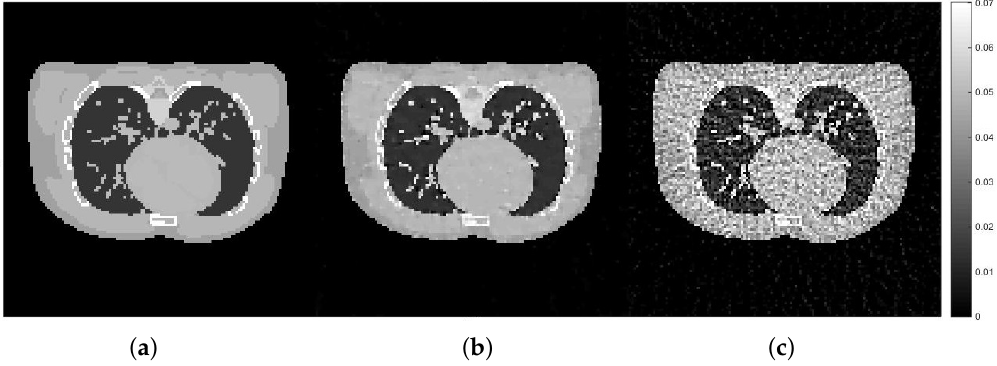
Figure 10. The reconstruction results of the experiment with second dataset: male phantom : ( a ) exact male phantom image, ( b ) with the best hyper-parameters using the proposed Hedge-based approach with the first dataset ( ng = 10, (cid:101) = 0, β = 1, β red = 0.99, δ = 0.0589), ( c ) with random hyper-parameters ( ng = 1, (cid:101) = 500, β = 1, β red = 0.99, δ =